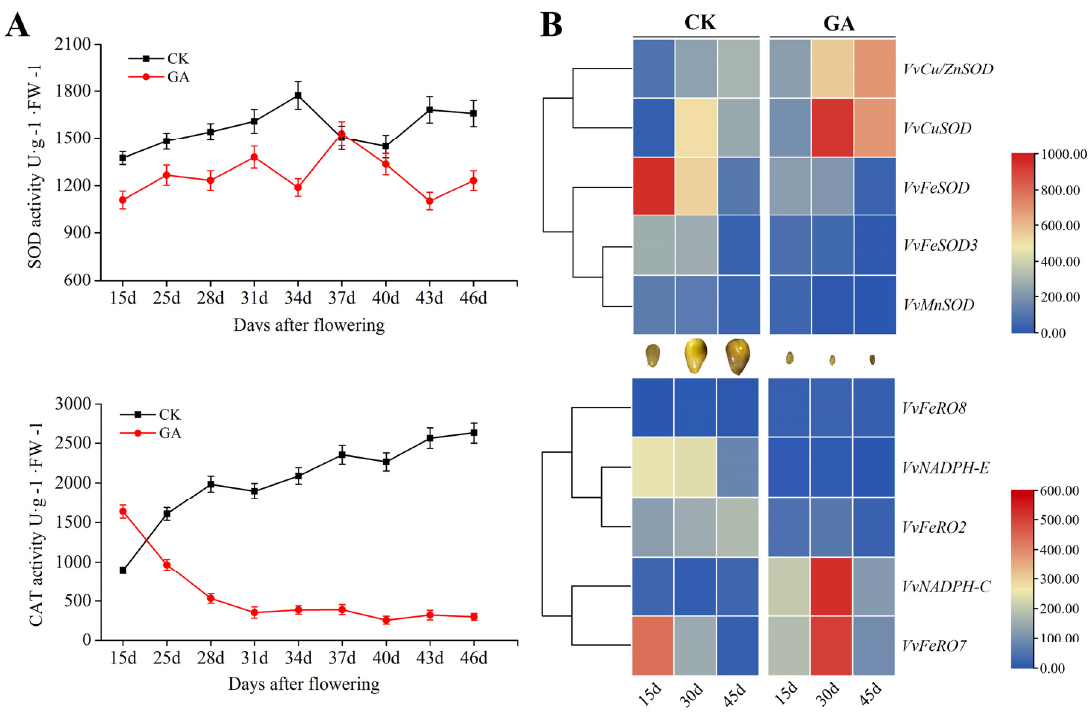
Figure 8. The activity of SOD and CAT enzymes ( A ) and the expression profile of members belonged to SOD and CAT family ( B ) during seed development in response to